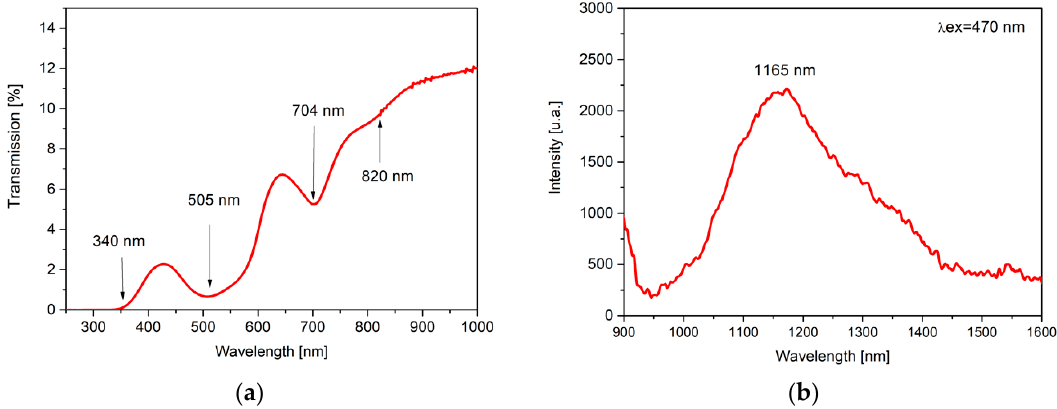
Figure 5. Optical transmission ( a ) and optical emission spectra ( b ) of 93GeO 2 –6Al 2 O 3 –1Bi 2 O 3 glass.